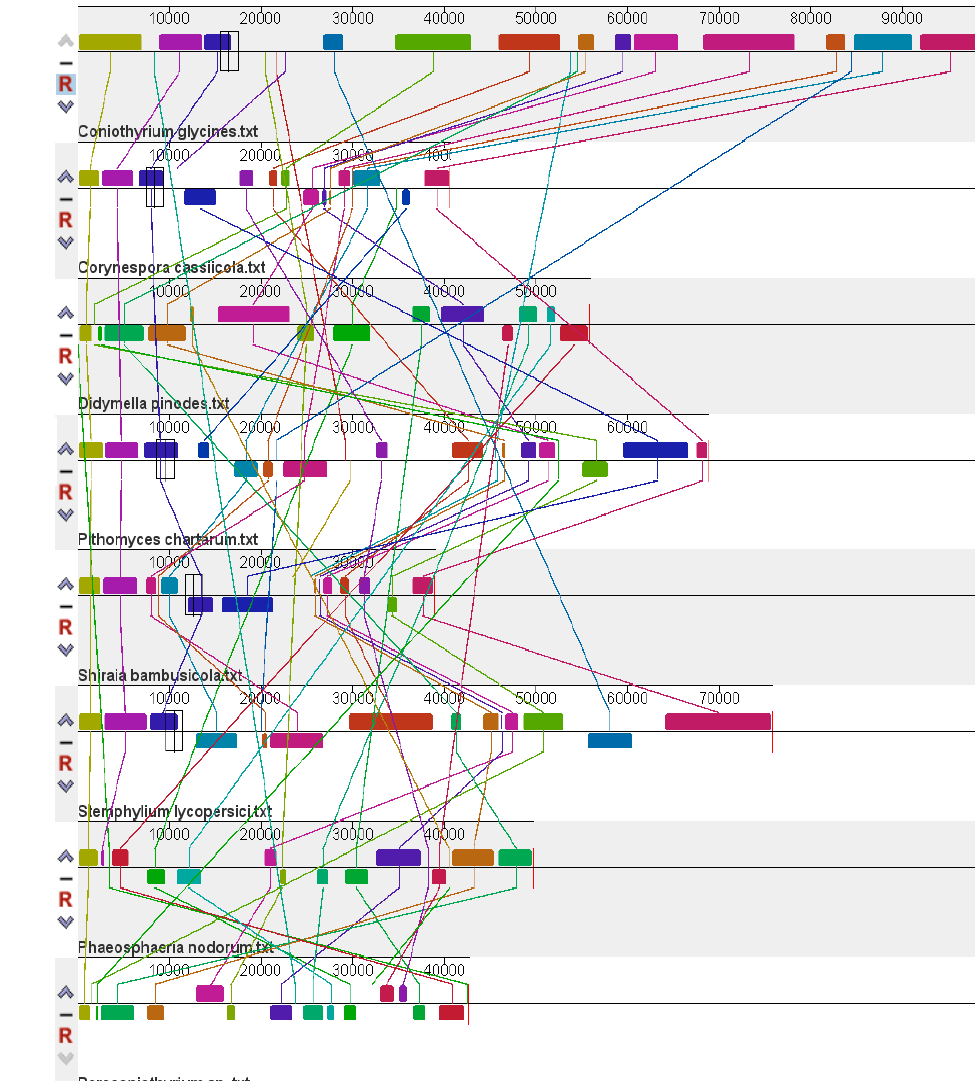
Figure 4. Whole mitochondrial alignments of 8 Pleosporales species.